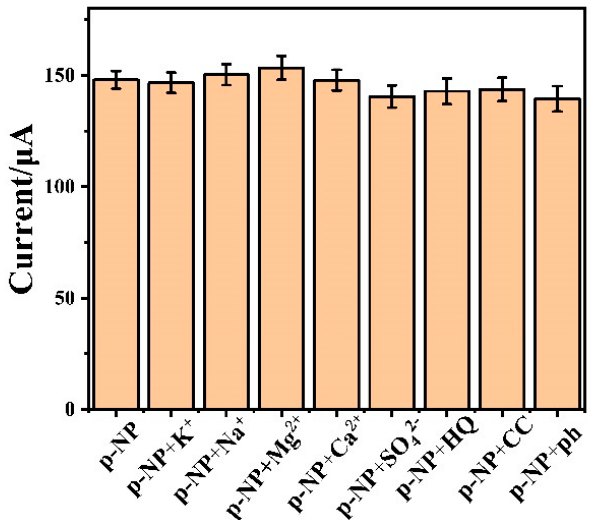
Figure 7. Effect of common interfering substances (0.5 mM) on electrochemical detection of p-NP (1.0 mM) for the Cr-MOF/GCE sensor in 0.1 M phosphate buffer solution (pH = 7.0).